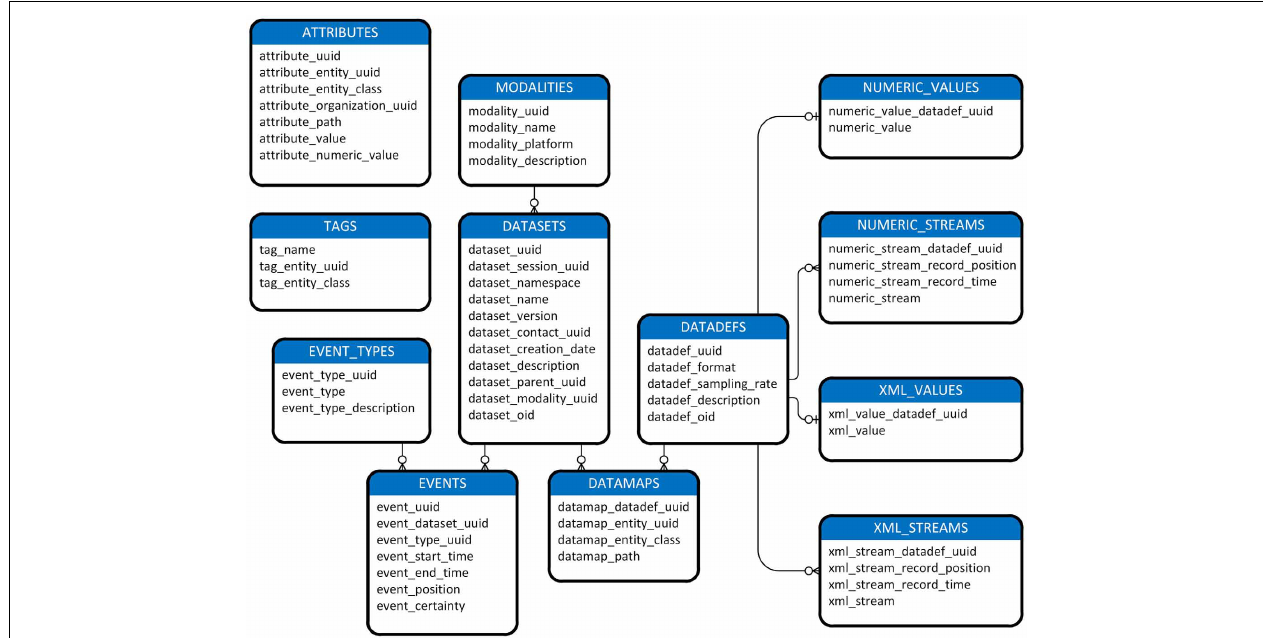
FIGURE 1 | A diagram of MOBBED data model. The connecting lines indicate an association between rows of two database tables. An unmarked end always indicates exactly 1 of that item. The o-| combination indicates zero or one of the corresponding item. For example, the connection between DATADEFS and NUMERIC_VALUES indicates that each row in the DATADEFS table corresponds to either zero or one row in the NUMERIC_VALUES table,